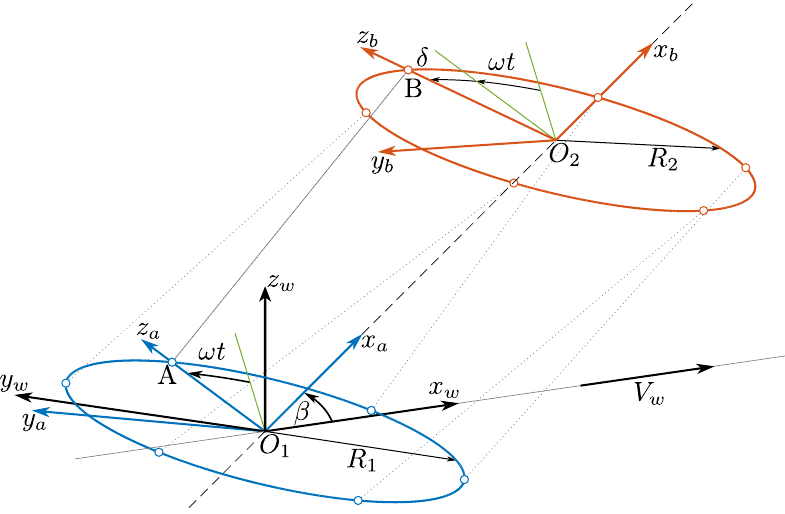
Figure 3. Representation of a single TRPT section within the Daisy Kite system